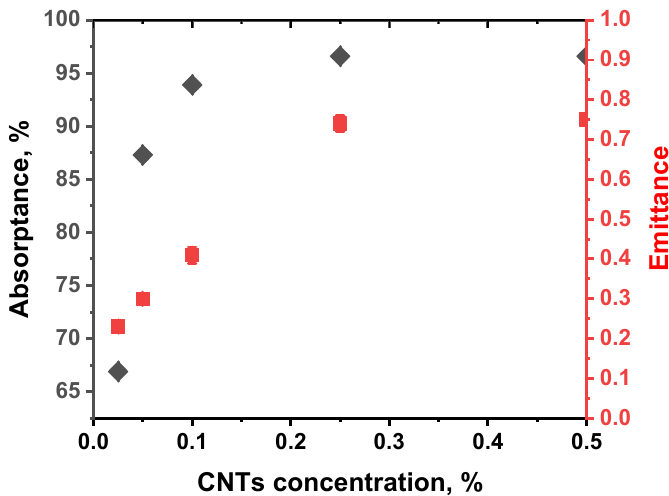
Figure 6. Absorptance and emittance of coatings as a function of Nanocyl CNT concentration in an N,N’-dimethylformamide (DMF)-based formulation without a binder. ( ◆ —Absorptance, ■ — Emittance).